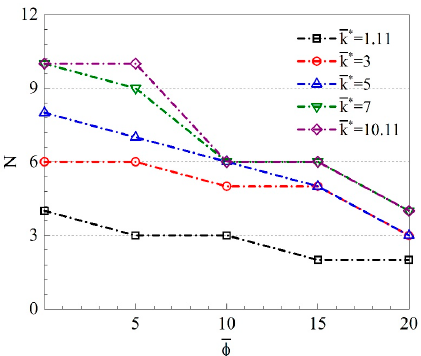
Figure 17. Change in bond strength.